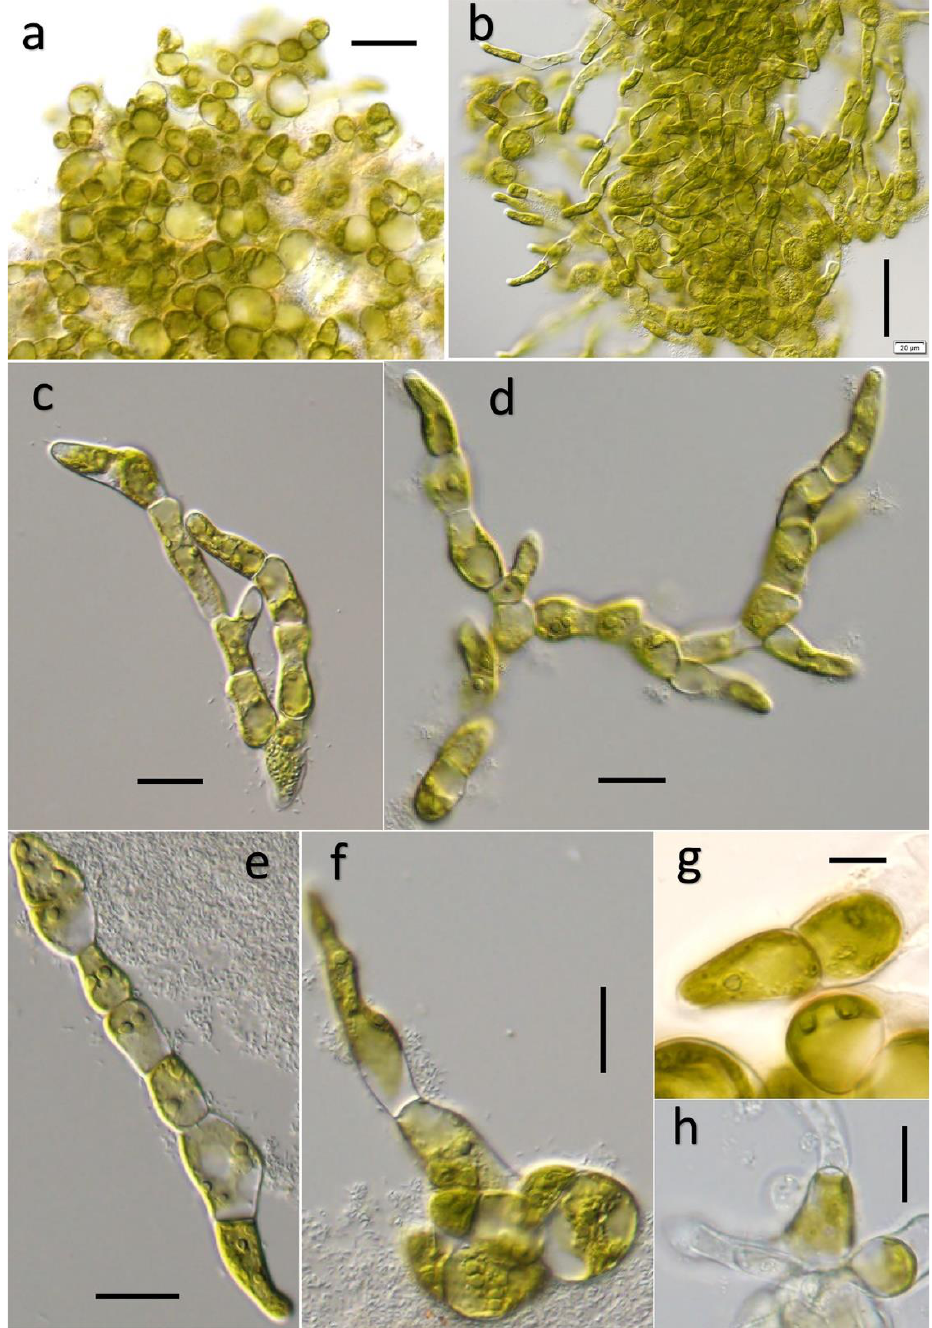
Figure 3. Culture sample morphology of Ulvella lacustris sp. nov.: ( a ) Compact prostrate filaments; ( b ) Cultured filaments are staggered and arranged compactly; ( c – e ) Thallus irregular filamentous branches or unbranched branches; ( f ) New filaments germinating from akinetes; ( g ) Clearly visible pyrenoids and chloroplasts; ( h ) Suspected empty sporangium. Scale bar: 50 μm ( a – b ), 20 μm ( c – f , h ), 10 μm ( g ).